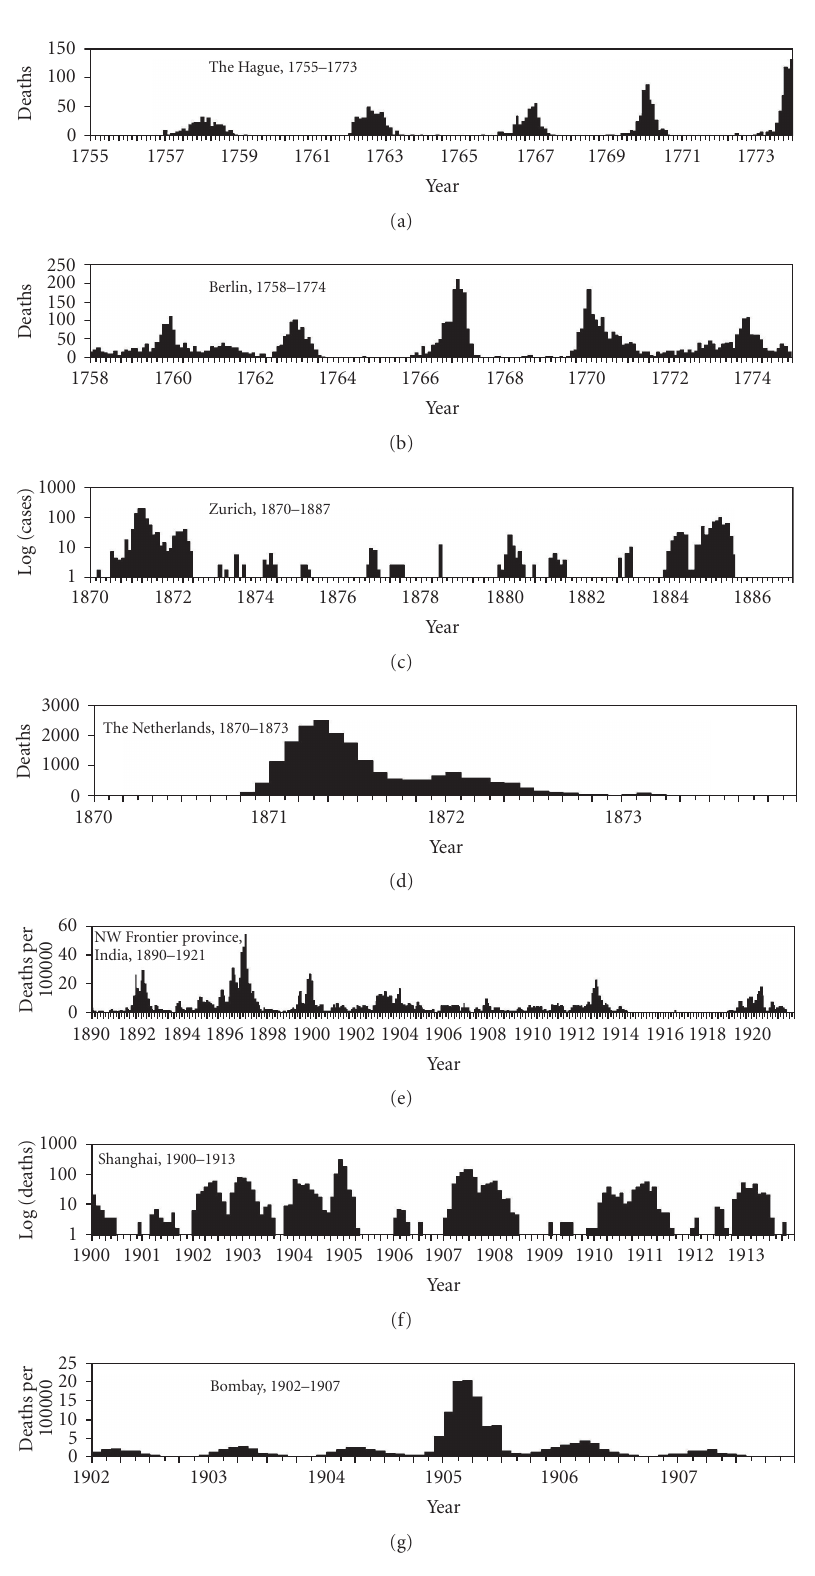
Figure 1: Temporal distributions of smallpox . Temporal patterns of smallpox are shown, which were extracted from historical records in (a) The Hague, The Netherlands, 1755–1773, (b) Berlin, Germany, from 1758–1774, (c) Zurich, Switzerland, 1870–1887, (d) the Entire Netherlands, 1870–1873, (e) Northwest Frontier province, India, 1890–1921, (f) Shanghai, China, 1900–1913, and (g) Bombay, India, 1902– 1907. Death data are shown in (a), (b), (d), and (f). Cases are shown in (c). Mortality (i.e., deaths per 100000) data are shown in (e) and (g). See [17, 39–45] for original